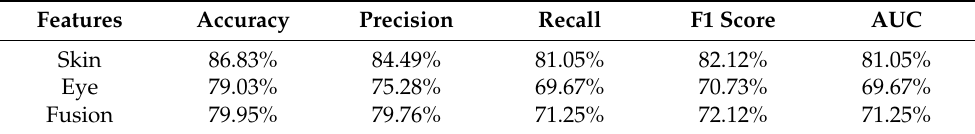
Table 4. Performance evaluation of the transfer learning model with different types of features.